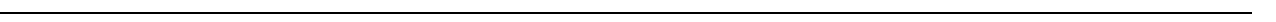
Fig. 4 Relationship of ancient Chinese cattle to present-day cattle and genetic diversity of the fi ve “ core ” cattle groups. a Neighbour-joining tree of the relationship between the ancient Chinese cattle and fi ve “ core ” groups. The scale bar represents the pairwise distances between different individuals. b Shared drift with ancient Shimao cattle in 42 modern-day cattle populations using the outgroup- f 3 statistics (Indicine cattle; Ancient, X ). The indicine cattle include three individuals of Hariana, Sahiwal and Tharparkar cattle. c Genome-wide distribution of nucleotide diversity of fi ve “ core ” cattle groups in 50-kb non-overlapping windows. The horizontal line inside the box corresponds to the median of this distribution, the bottom and top of the box are the fi rst and third quartiles. Data points outside the whiskers can be considered as outliers. d Venn diagram showing unique and shared SNPs among the fi ve “ core ” cattle